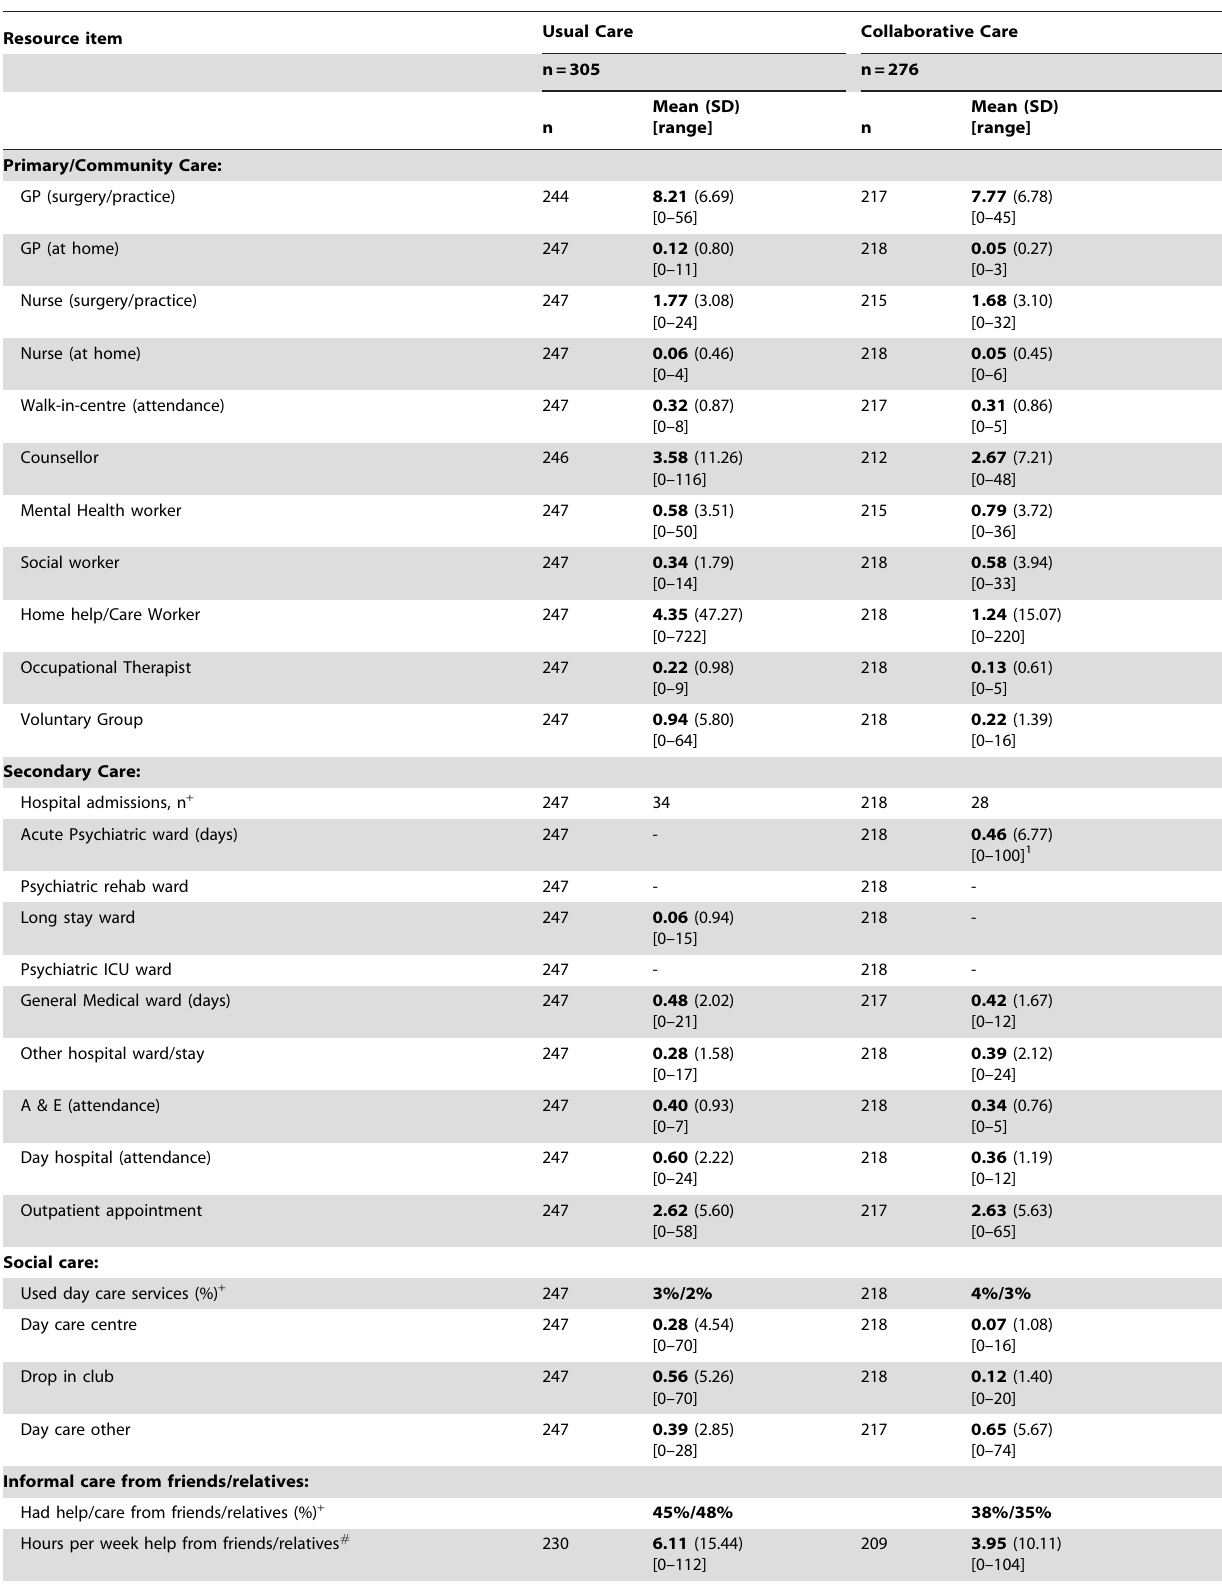
Table 2. Mean health and social care resource use (quantities) over 12 month follow-up.